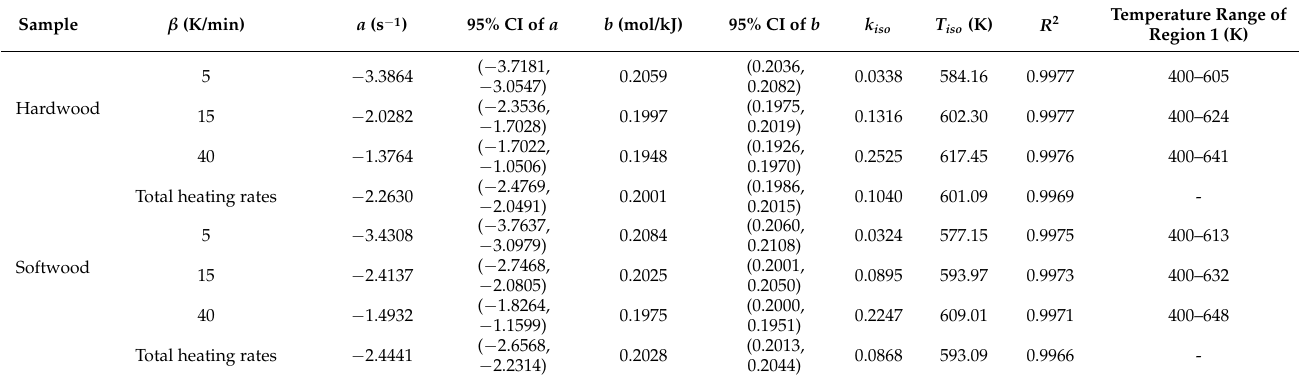
Figure 6. The kinetic compensation effect of region 1 for ( a ) hardwood and ( b ) softwood. Table 6. KCE parameters and corresponding R 2